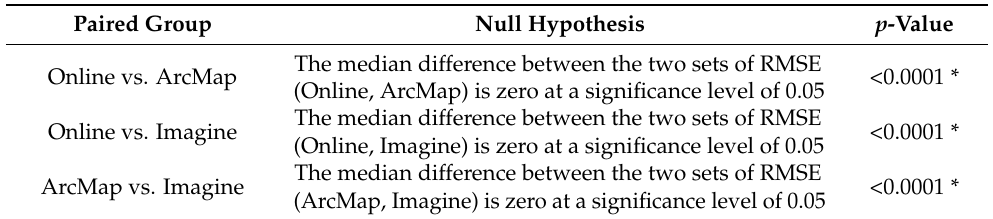
Table 4. The Descriptive Statistics for Each Georeferencing Platform’s RMSE.